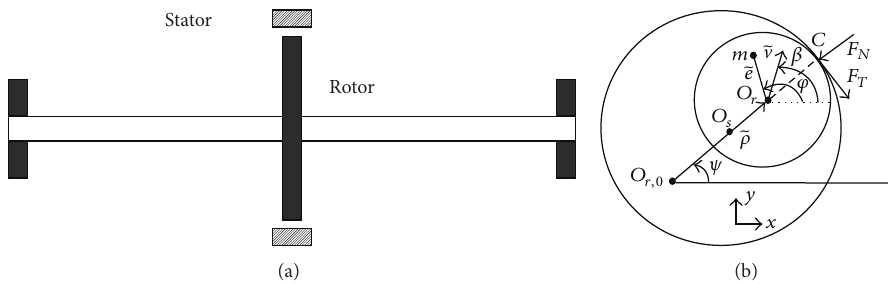
Figure 1: (a) The schematic plot of the rotor-to-stator system; (b) the section view on the plane of the rotor and the stator ring.